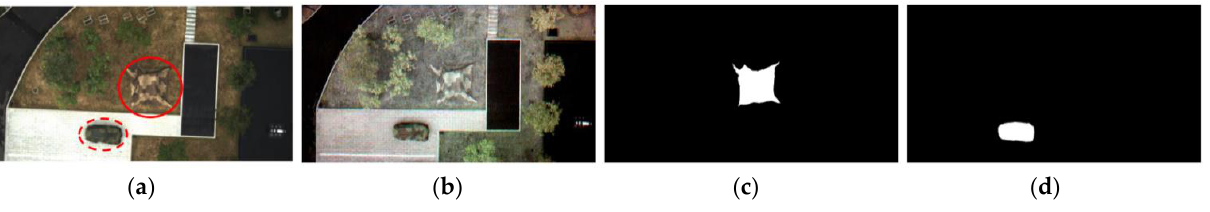
Figure 20. ( a ) The visible image of the UAV scene. The camouflaged tent is circled by the solid line. The camouflaged vehicle is circled by the dashed line; ( b ) The false-color image of the UAV scene; ( c ) The reference image of the camouflaged tent; ( d ) The reference image of the camouflaged vehicle.